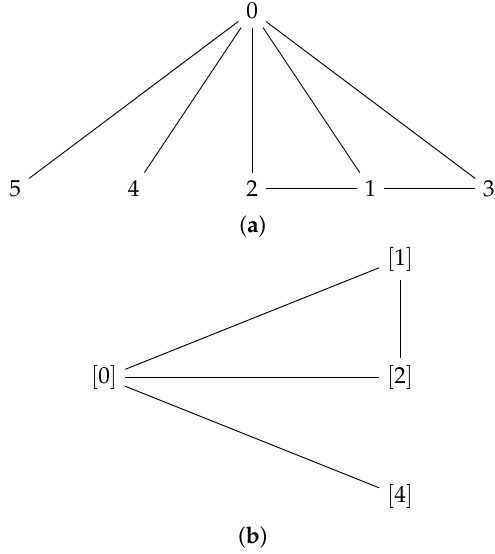
Figure 2. ( a ) Graph of G ( A ) ; ( b ) graph of G E ( A ) .